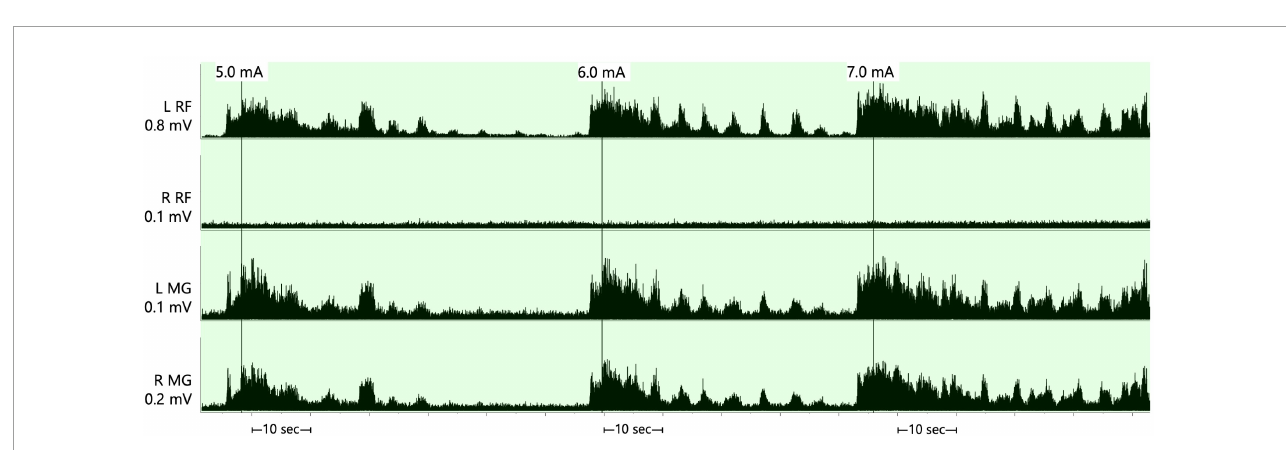
FIGURE2 Supine rhythmic electromyography (EMG) activities of the left and right rectus femoris (RF) and medical gastrocnemius muscles initiated when the stimulation parameters were set at a frequency of 25 Hz, pulse duration of 250 µ s and amplitude of the current that progressed from 5.0–7.0 mA after configuring the cathode at –0 and the anode at +3. The rhythmicity pattern resulted in periods of EMG bursts that followed by periods of relaxation in three out of the four muscle groups and was less obvious in the right rectus femoris muscle. The EMGs presented are rectified and bandpass filtered at 10–990 Hz. RF, rectus femoris; MG, medial gastrocnemius; mV, millivolts; mA, milliamps; sec,